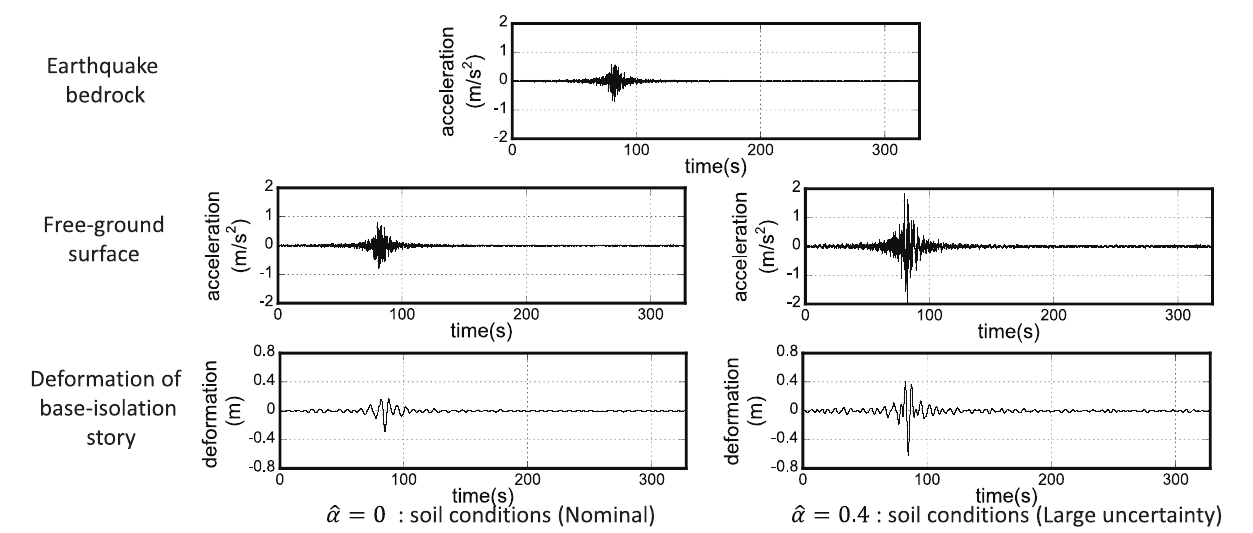
FIGURE 7 | Generated acceleration wave at earthquake bedrock, generated acceleration wave at free-ground surface, and generated deformation at base-isolation story for two uncertainty levels ^ α = 0 ; 0 : 4 of deep ground properties (Tokyo area).